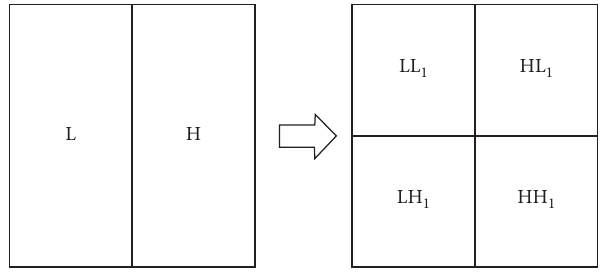
Figure 4: Wavelet decomposition